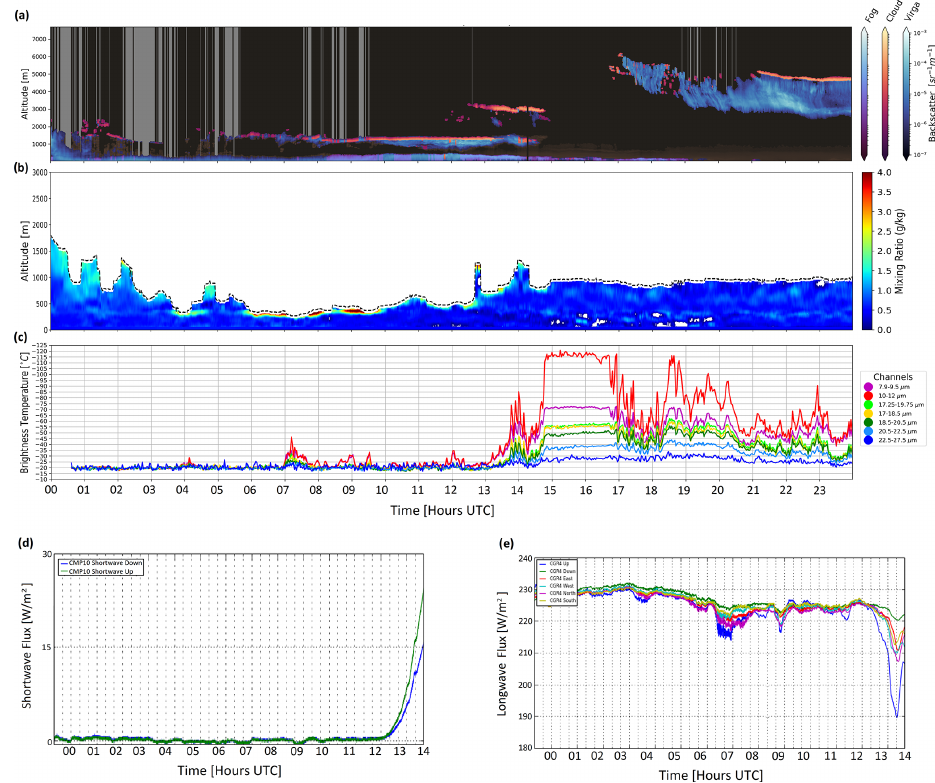
Figure 7. Multi-instrument observations at the Iqaluit supersite during a blizzard on 23 November 2018, including (a) CL51 ceilometer aerosol backscatter observations coloured by meteorological type classification (clear skies, fog, cloud, and virga), (b) DIAL water vapour mixing ratio profiles up to the instruments’ effective height (black dashed line), (c) downwelling brightness temperature measurements from the FIRR’s seven channels, (d) CMP10 shortwave upward (green) and downward (blue) radiation fluxes, and (e) CGR4 longwave upward (blue), downward (green), eastward (red), westward (teal), northward (purple), and southward (yellow) radiation fluxes. Note that panels (d) and (e) are only shown up to 14:00UTC due to an instrument malfunction, whereas panels (a) – (c) are shown for the entire